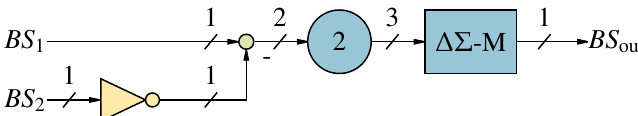
Figure 14. The ∆Σ SP operation addition performed with Advanced Quanta Decoding.